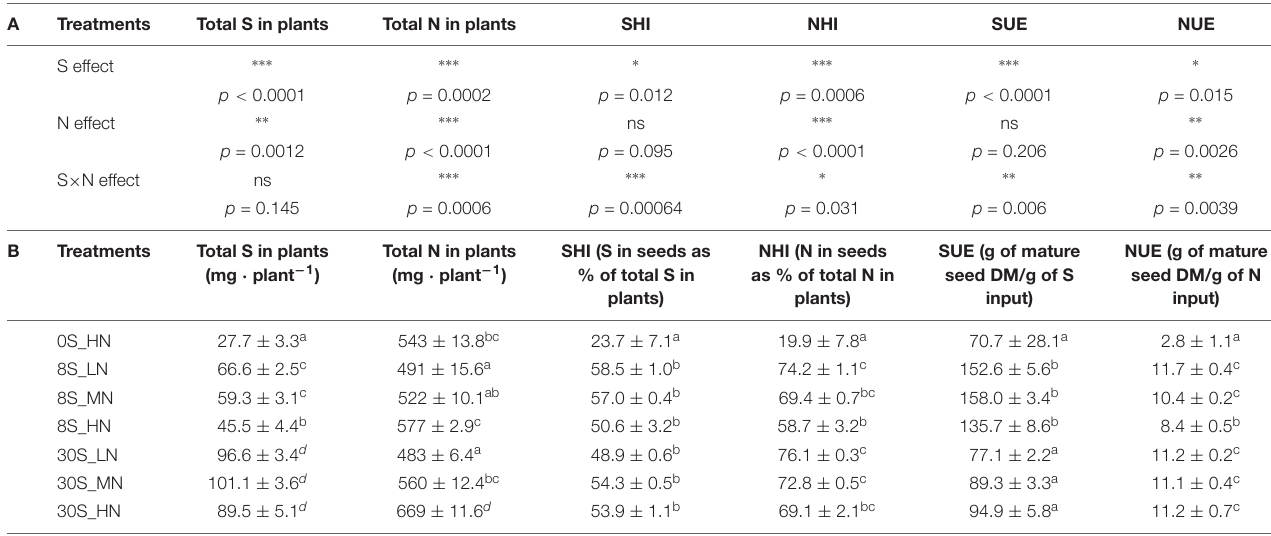
TABLE 2 | S, N, and S × N effects on total N in plants, total S in plants, the NHI, the SHI, N use efficiency (NUE), and S use efficiency (SUE) (A) and total N in plants (mg plant − 1 ), total S in plants (mg plant − 1 ), the NHI (N in seeds as % of total N in plants), the SHI (S in seeds as % of total S in plants), NUE (g of mature seed DM per